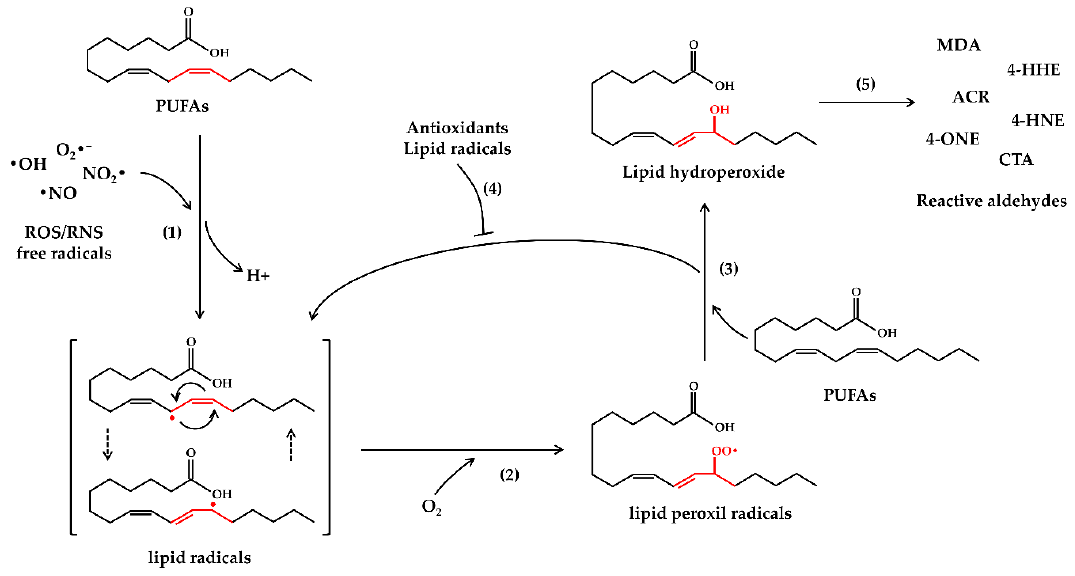
Figure 1. Schematic diagram of the free radicals-mediated peroxidation of polyunsatured fatty acids (PUFAs). ROS/RNS: reactive oxygen and nitrogen species; ACR: acrolein; MDA: malondialdehyde; CTA: crotonaldehyde; 4-HNE: 4-hydroxy-2-nonenal; 4-HHE: 4-hydroxy-hexanal; 4-ONE: 4-oxo-nonenal. During the initiation phase (1), ROS/RNS free radicals react with PUFAs and rip off an allylic hydrogen thus forming lipid radicals. Generally, lipid radicals tend to be stabilized by a molecular rearrangement. (2) In the propagation phase, lipid radicals react with oxygen to form lipid peroxyl radicals, which in turn react with PUFAs or other nearby lipids resulting in the formation of new lipid radicals and lipid hydroperoxides (3). During the termination phase (4), antioxidants or lipid radicals block the propagation phase by donating a hydrogen atom to lipid peroxyl radicals resulting in the formation of non-radical products. Nevertheless, lipid hydroperoxides are highly unstable therefore they are further degraded into reactive secondary products such as ACR, MDA, 4-HNE, and other reactive aldehydes (5).